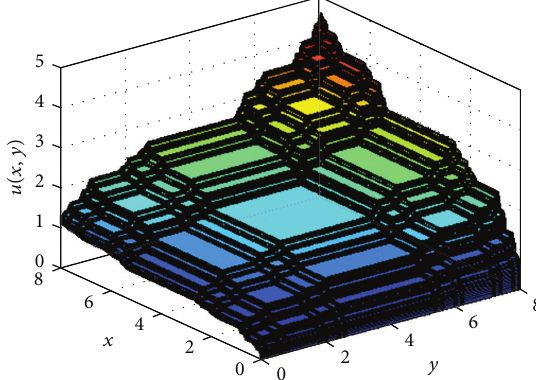
Figure 1: Graph of 𝑢(𝑥,𝑦) for 𝛼 = ln 2/ ln 3